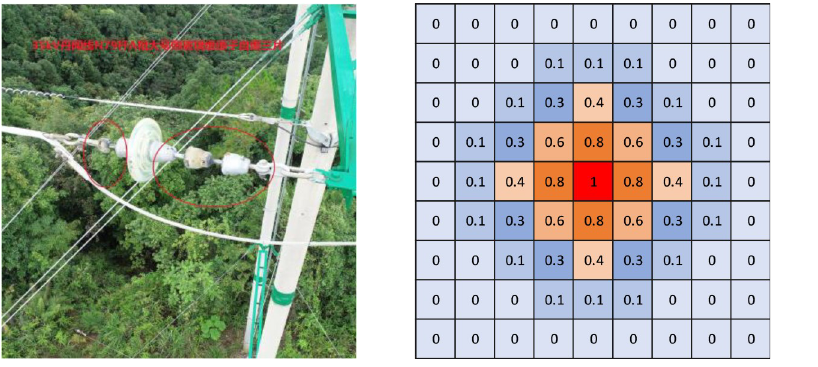
Fig 5. The center heatmap icon. (a) Original image, (b) Gaussian